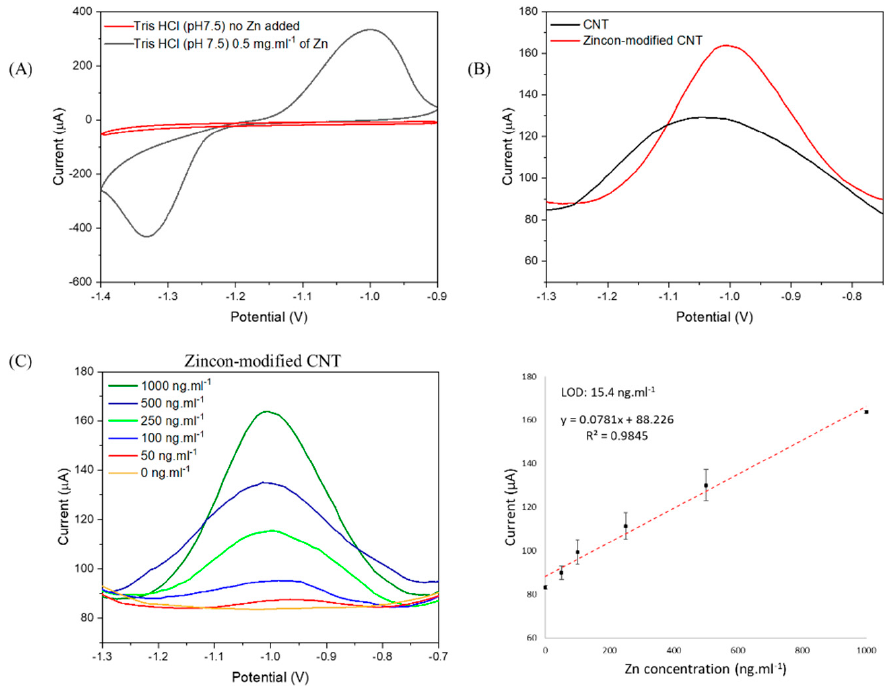
Figure 5. Study of the electrochemical detection of Zn +2 on 0.1 M Tris–HCl (pH 7.5) solution. ( A ) CV in absence and presence of 0.5 mg · mL − 1 of Zn +2 . ( B ) SWV showing the increase of current after grafting of zincon on CNT in Tris–HCl solution containing concentration of Zn +2 = 1 µ g · mL − 1 , and ( C ) SWV of zincon–modified CNT varying Zn +2 concentration from 0 to 1000 ng · mL − 1 and its linear fit (n = 3).